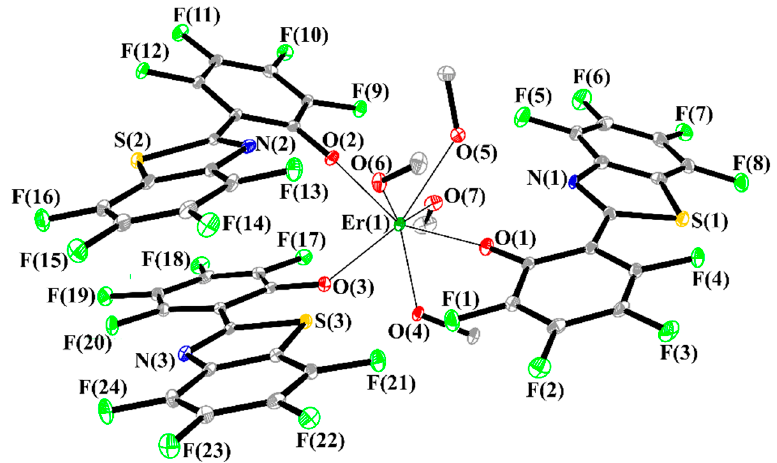
Figure 4. Molecular structure of 7 (thermal ellipsoids are drawn at 30% probability; hydrogen atoms are omitted for clarity). Selected distances (Å) and angles (°) in 7 : Er(1)–O(1) 2.177(2), Er(1)–O(2)